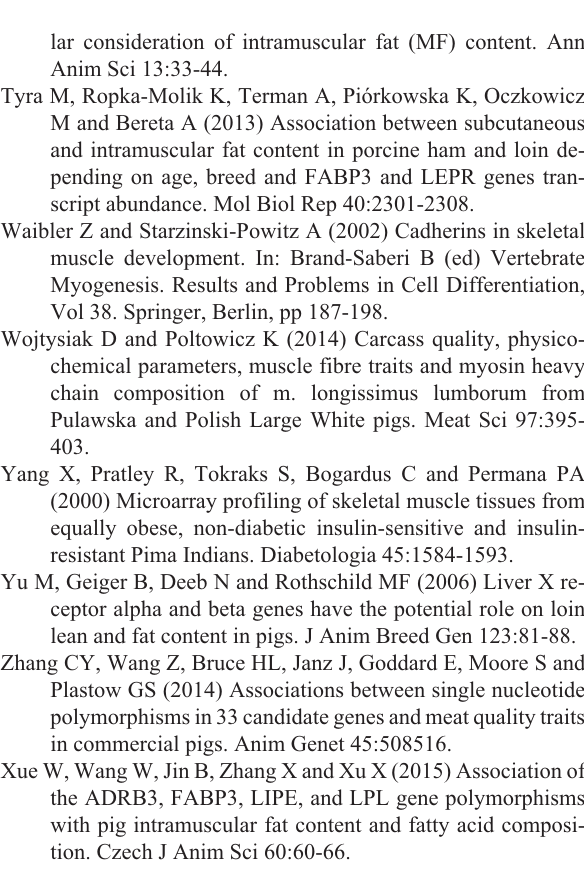
Table S1 - Overall statistics and read annotations obtained for each library. Table S2 - Primer and TaqMan probes used in validation. Table S3 – Genes differentially expressed in semimembranosus muscle of Polish Landrace pigs. Table S4 - Pearson correlation coefficient for DEGs in longissimus dorsi and pig production traits. Table S5 - Correlation coefficient for DEGs in semimembranosus and pig production